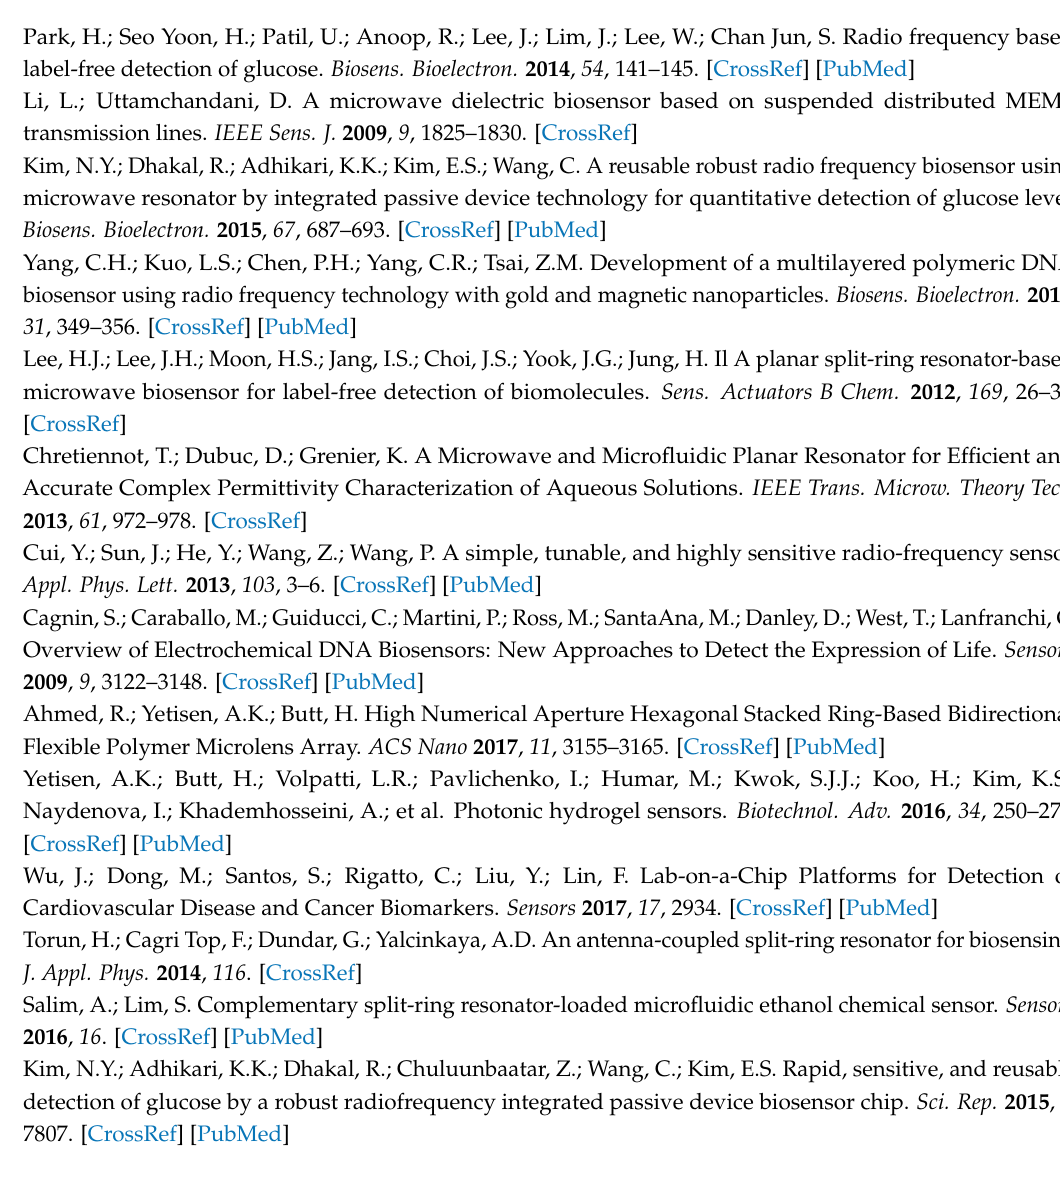
Figure S3: Loaded capacitance versus relative permittivity, and Table S1: Measured resonance frequencies (in GHz) and corresponding rejection levels (in dB) for three different